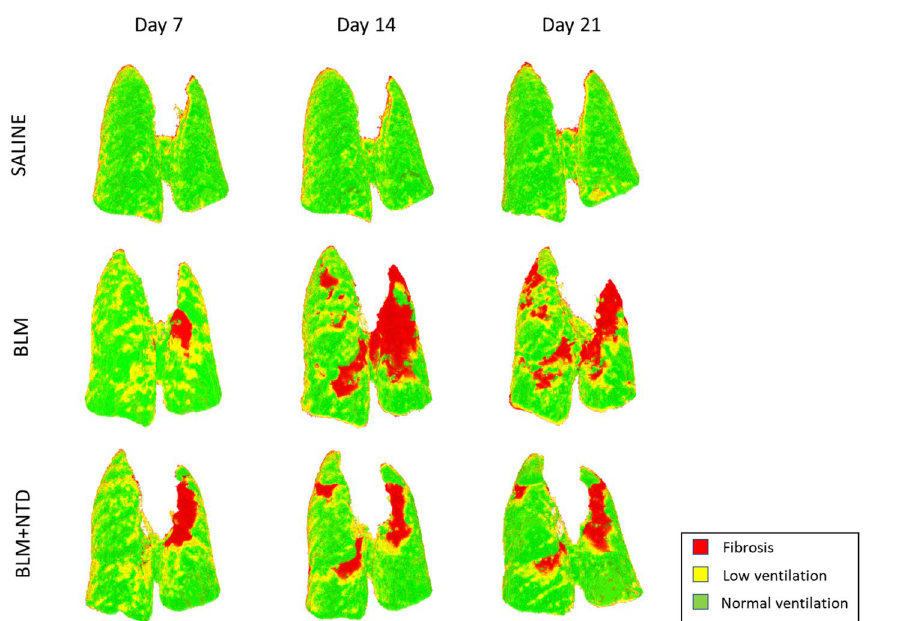
Figure 6. Functional maps in a saline (top) and a representative BLM (middle) and BLM + NTD (bottom) animal at all timepoints. In the saline, the lungs are normally ventilated. In the BLM animal, at day 7, On the functional map, only a small region of the left lung was fibrotic. At day 14, a large fibrotic region in the upper left lung was present, which widened at day 21, also affecting the right lung. In the BLM + NTD animal, a small fibrotic region was present on day 7 in the left lung, which remained stable in the following